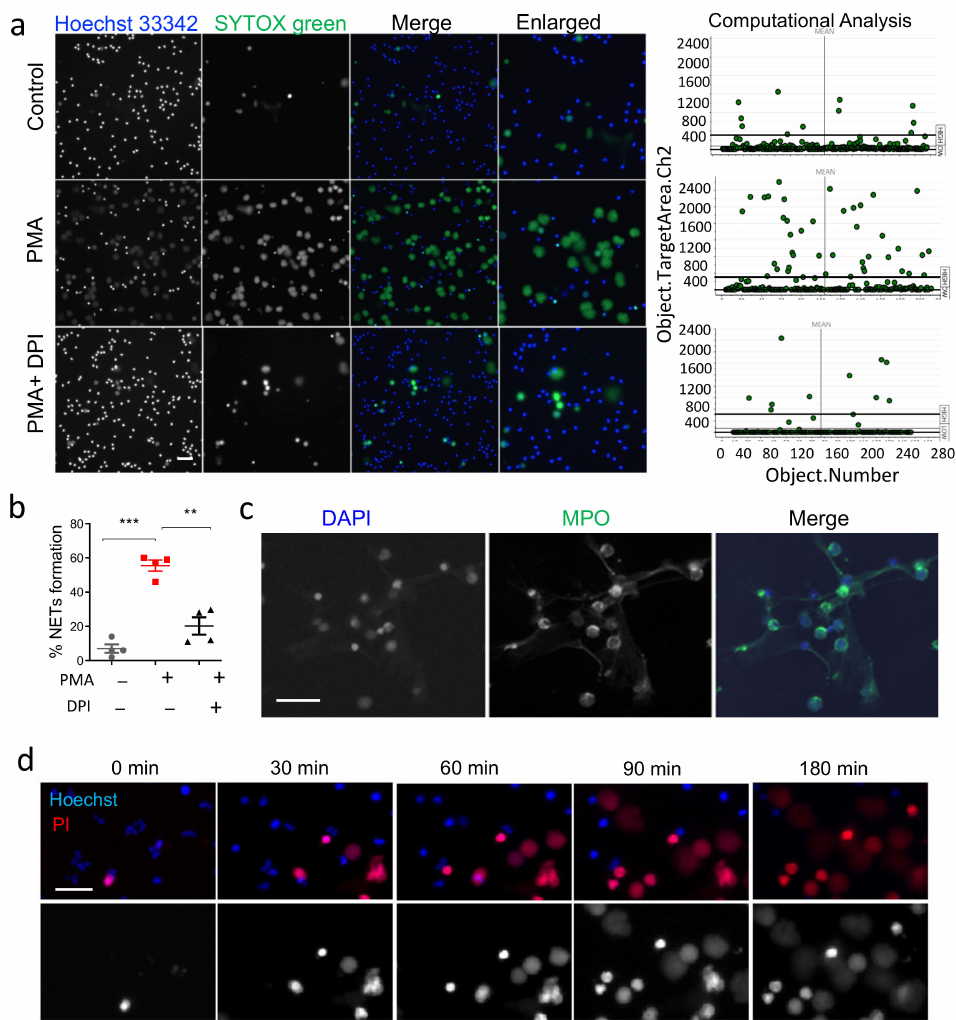
Figure 2. Analysis of PMA-induced NETs using HCS studio software and its inhibition by DPI. ( a ) Left side, representative images of control and neutrophils stimulated with 100 nM PMA and 10 µ M of DPI at 3 h. The cells were identified using Hoechst 33342, a cell permeable nuclear dye that labeled nucleus in all cells. NETs were identified as positive for cell impermeable Sytox green and enlarged cells, scale bar; 50 µ m. On right side, scattered plots represent HCS-based computational analysis of NETosis using object area channel 2. The percentage of NET forming cells were calculated as Sytox positive nuclei out of total Hoechst positive cells. ( b ) The effect of 10 µ M DPI on PMA stimulated NETs, percentage of neutrophils. ( c ) Representative immuno-staining pictures of PMA- stimulated neutrophils at similar condition confirming validity of HCS-based measurements. ( d ) Time lapse analysis of PMA-induced neutrophils using Hoechst 33342 and PI dyes. ** p < 0.01, *** p < 0.001; Data are means ±